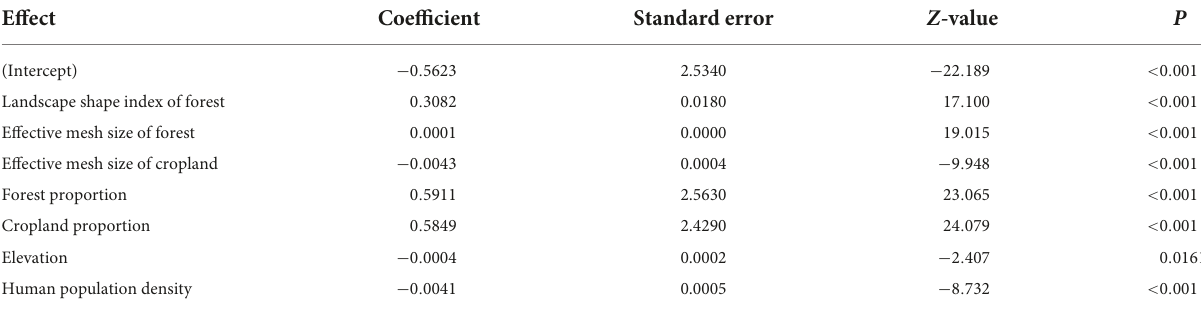
TABLE 2 Results of the Poisson regression analysis relating human-bear conflicts to various covariates around Baoshan Section of Gaoligongshan Nature Reserve during 2012–2020. Effect Coefficient Standard error Z